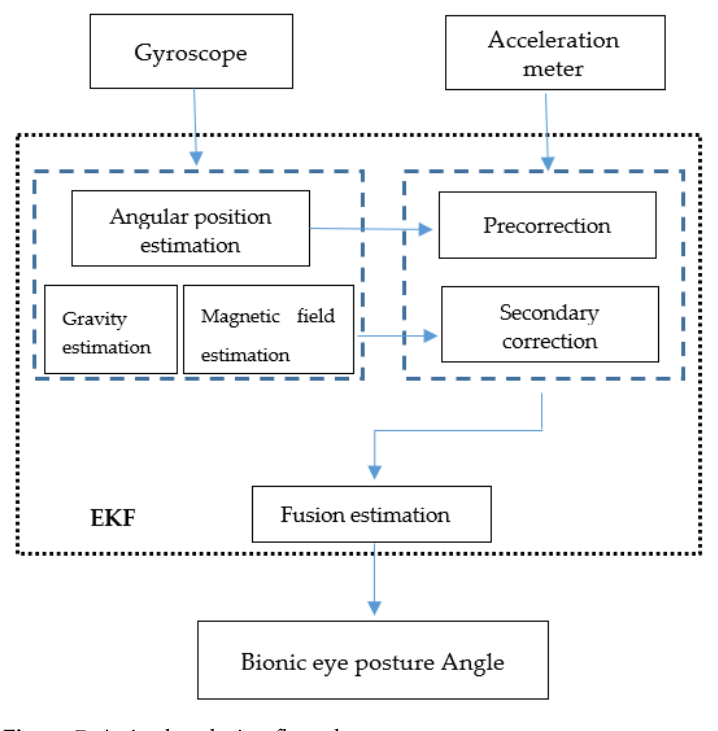
Figure 7. Attitude solution flow chart.